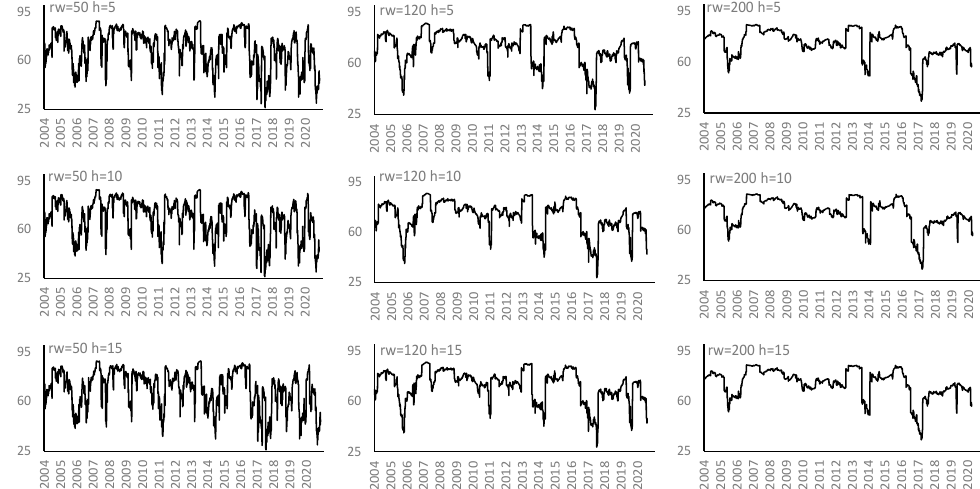
Figure 4. Robustness test of the inter-sector spillover index of China’s stock market.